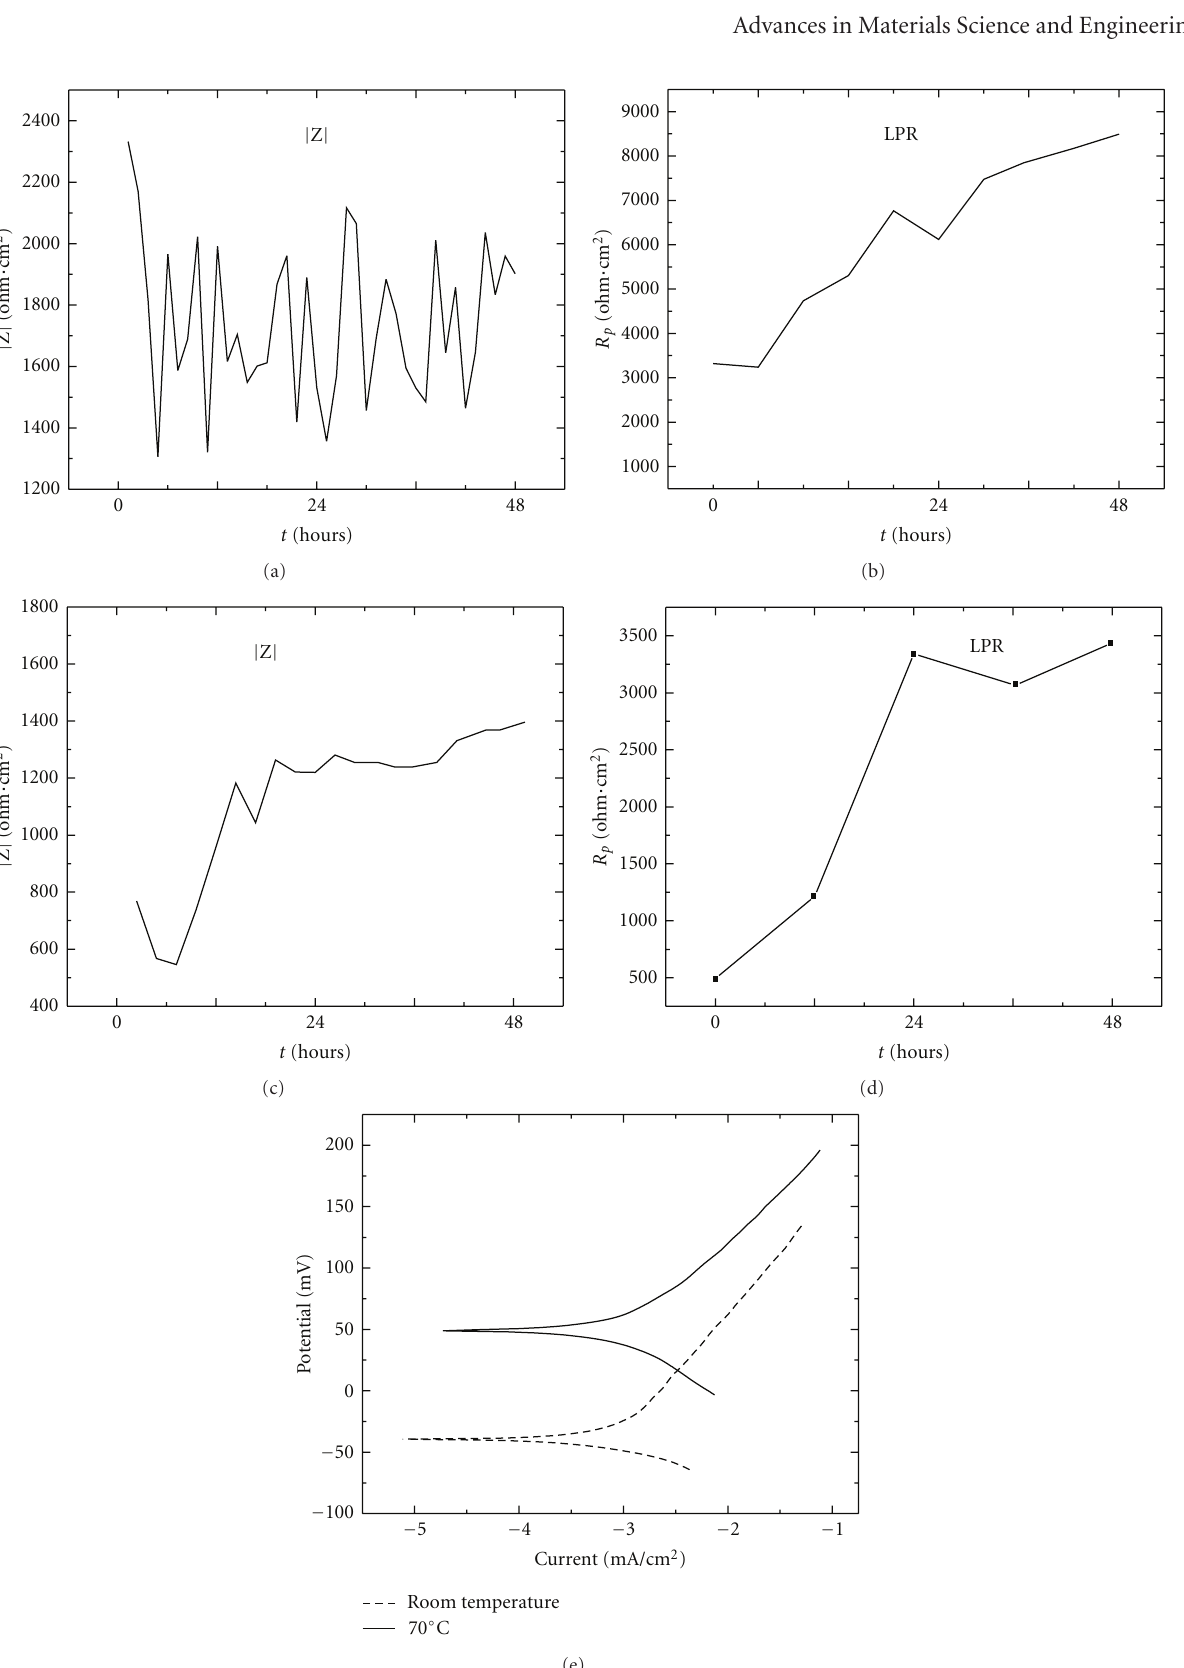
Figure 8: Electrochemical tests plots in the pH 11 solution, (a) | Z | at room temperature for 48 hours, (b) R p at room temperature for 48 hours, (c) | Z | at 70 ◦ C for 48 hours, (d) R p at 70 ◦ C for 48 hours, and (e) polarization curves at room temperature and 70 ◦